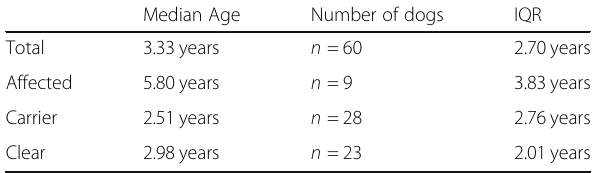
Table 7 Age of SP with comparison between